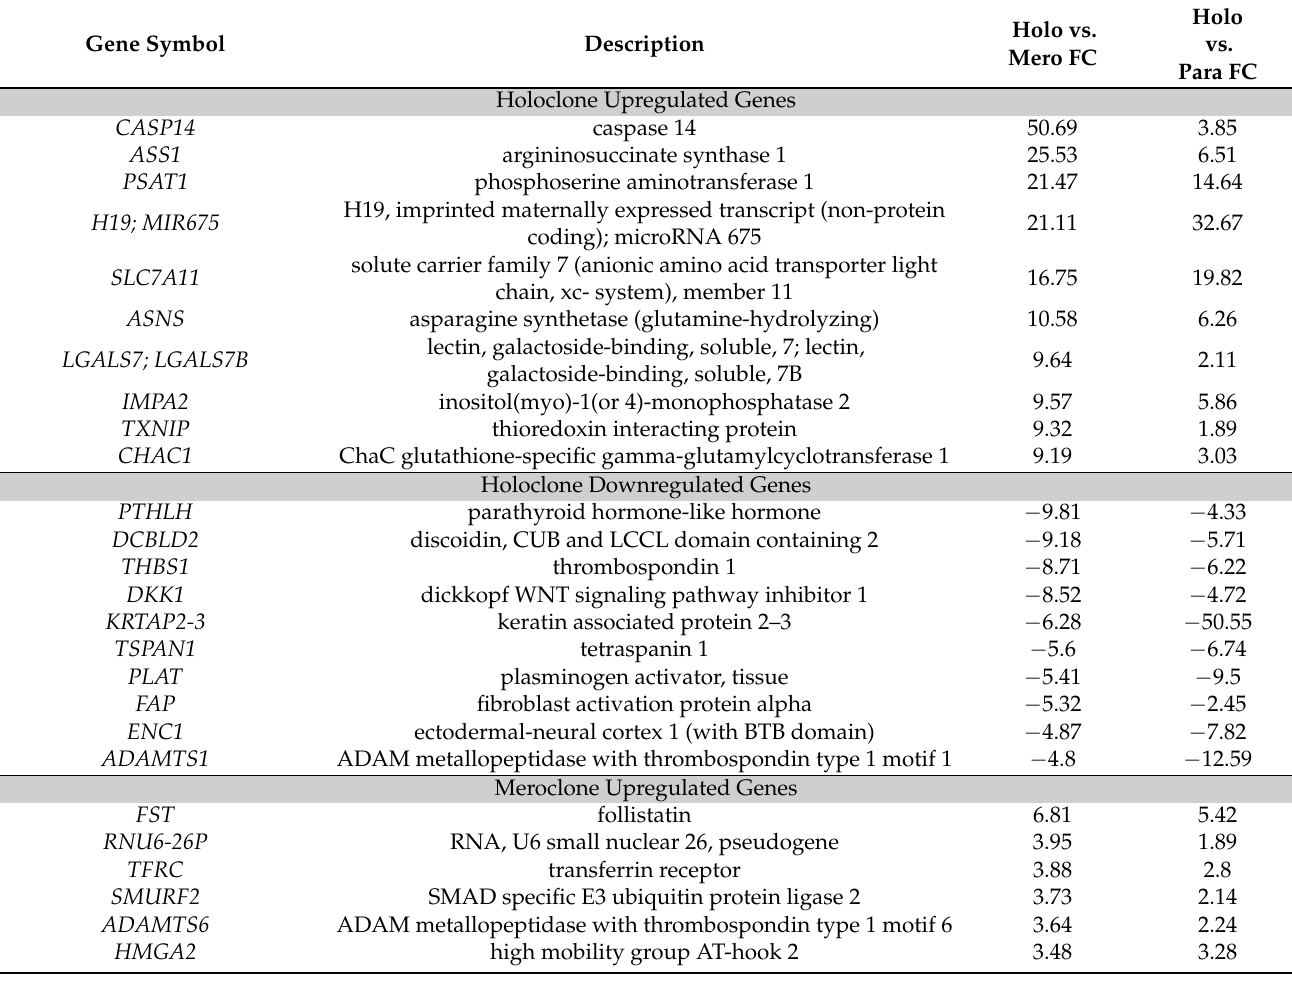
Table 1. Top signature genes up- or downregulated uniquely in each clonal